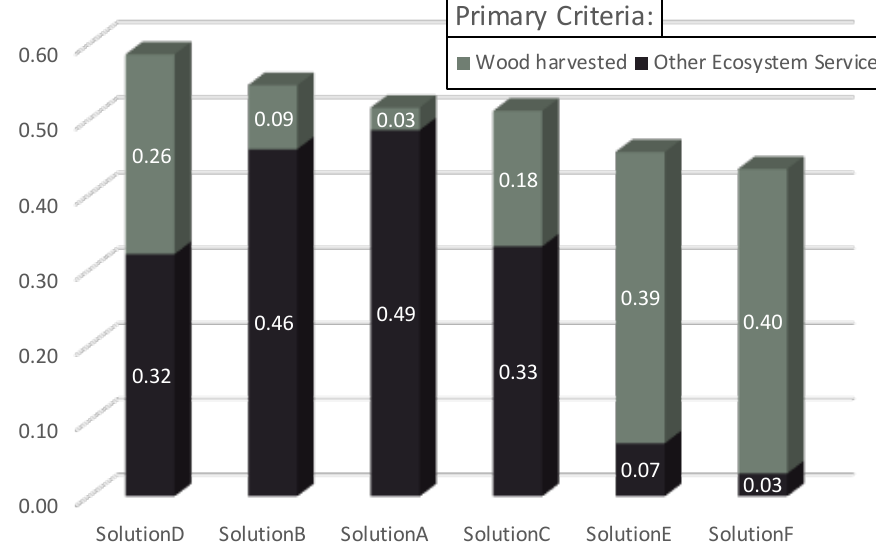
Figure 5. Contributions of primary decision criteria (Figure 4) to the overall CDP utility score for the six solutions (A to F) from the Pareto frontier analysis (Figure 3).